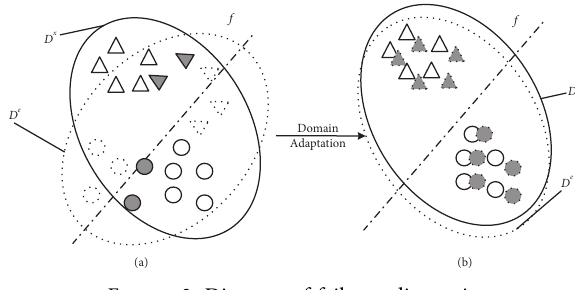
Figure 3: Diagram of failover